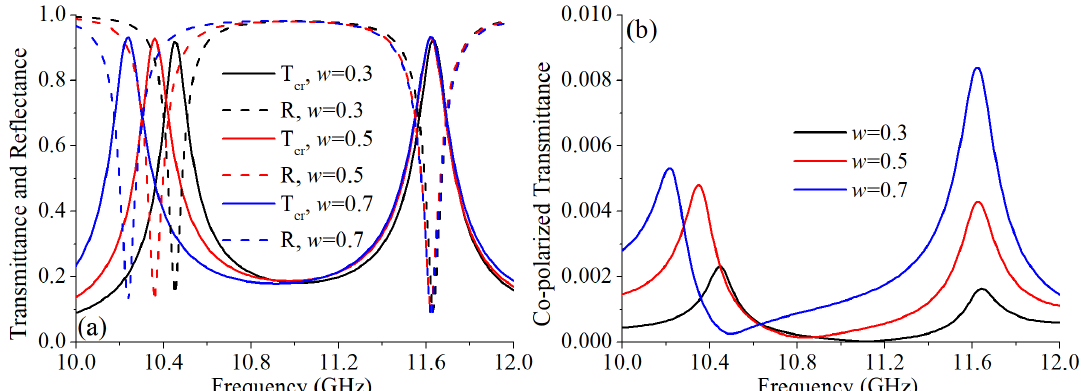
Figure 6. Simulation results with different w : ( a ) The simulated cross-polarized transmittance and reflectance. ( b ) The simulated co-polarized